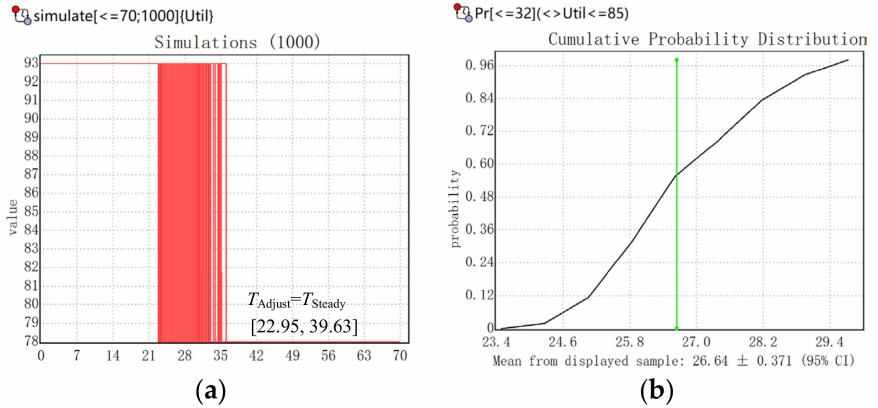
Figure 13. Time behaviors of the optimized SUIS application: ( a ) the changes of CPU utilization; and ( b ) the average value of TAdjust and